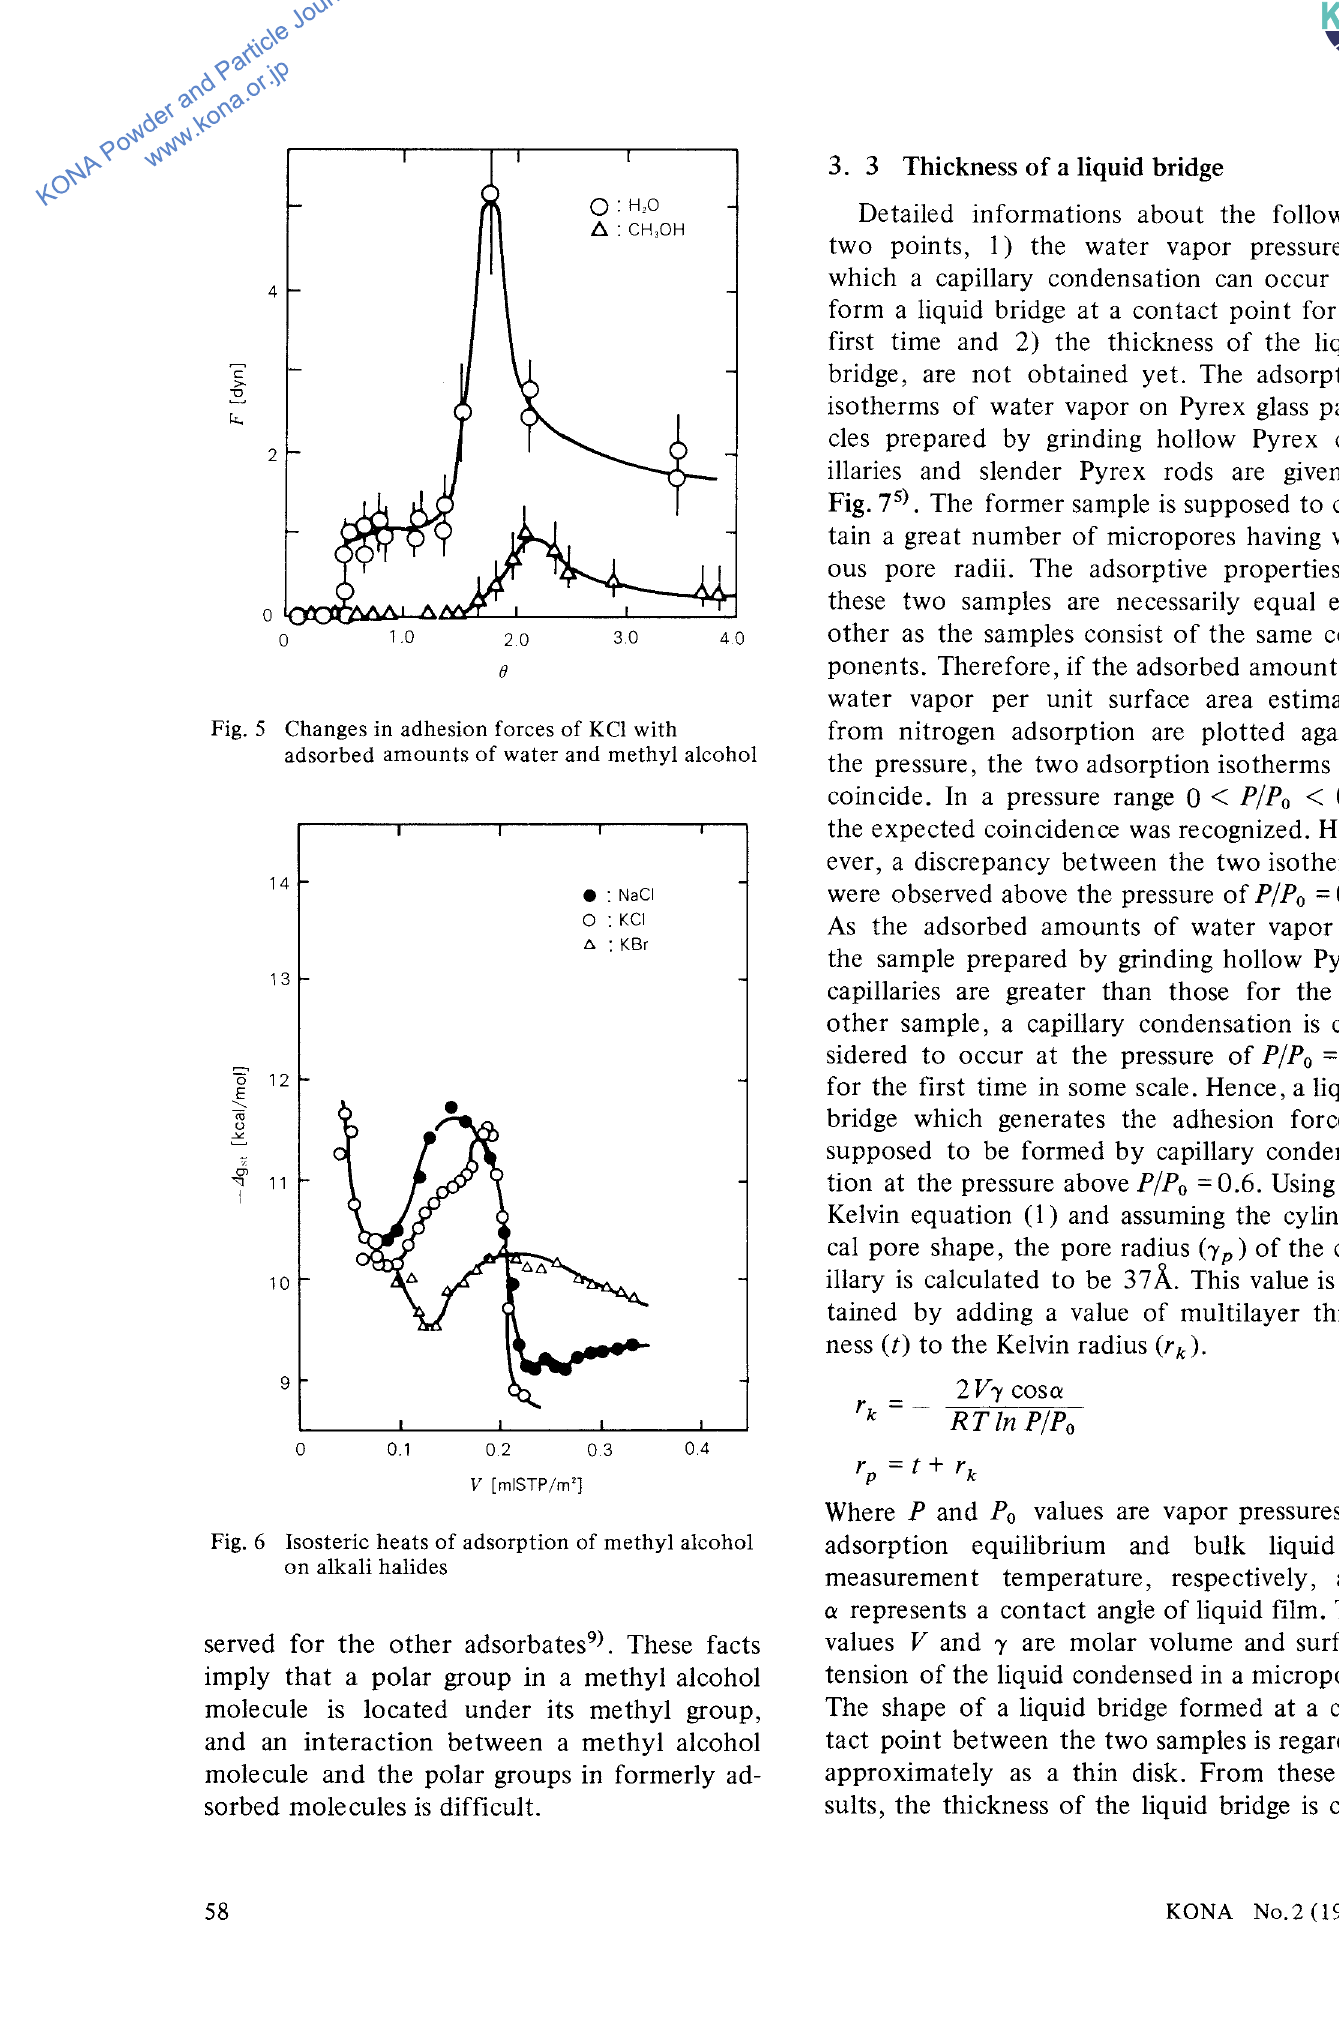
Fig. 5 Changes in adhesion forces of KCl with